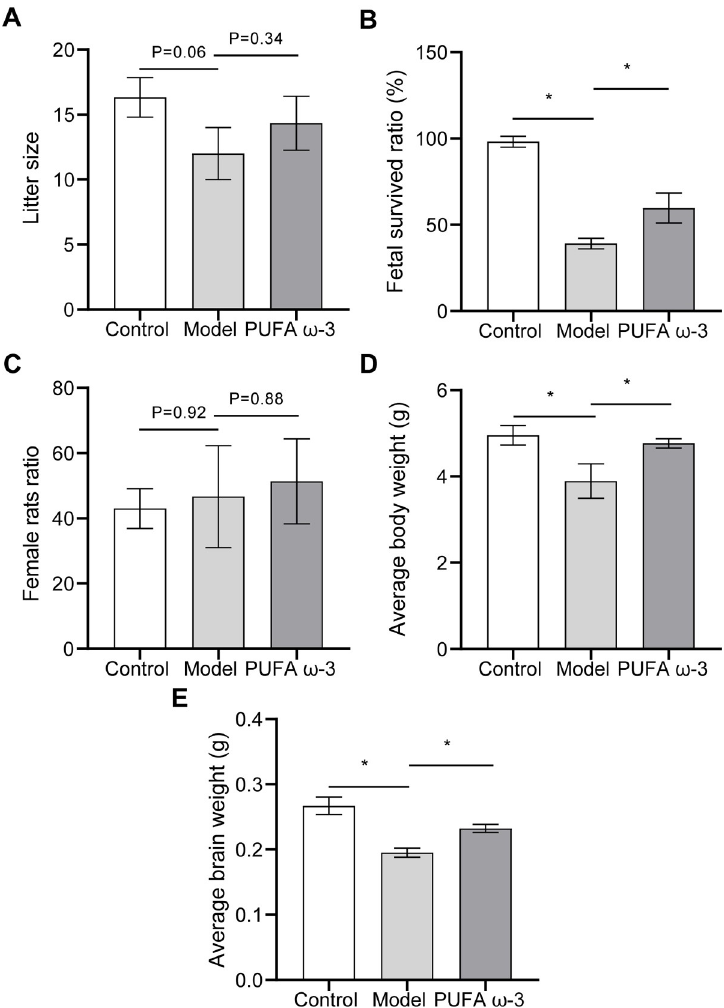
Fig 2. PUFA ω -3 ameliorates adverse pregnancy outcomes following sodium nitrite exposure during pregnancy. (A) The number of fetuses per litter, (B) The fetal survived ratio, (C) female rats ratio, (D) average body weight, and (E) average brain weight were measured and recorded. � P < 0.05, n = 3 rats/group.